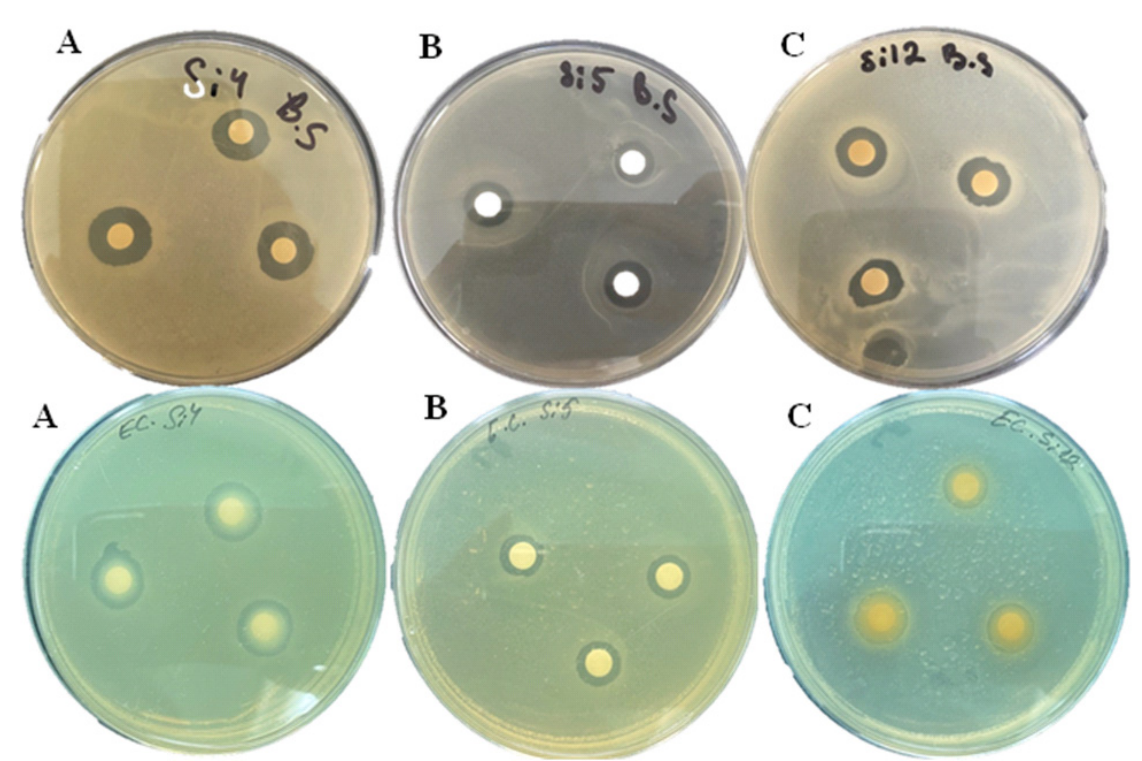
Figure 3. Antibacterial activity against B. subtilis 3562 (upper panel) and E. coli K12 407 (bottom panel) as test microorganisms for ( A ) Si4, ( B ) Si5 and ( C ) Si12. Antifungal activity of selected compounds is presented in Supplementary Materials. Table 4. Antimicrobial activity expressed as inhibition zones size (mm) against several test microorganisms. Code Structures